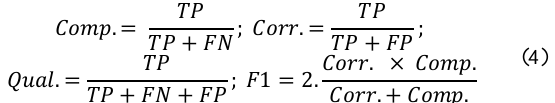
Metric Roof -line